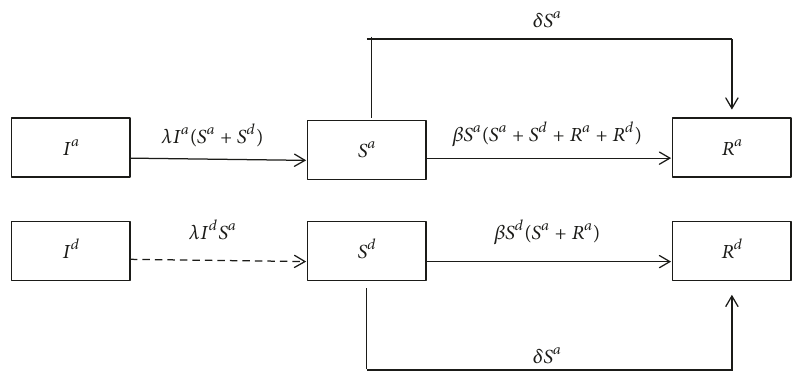
Figure 1: Rumor spreading